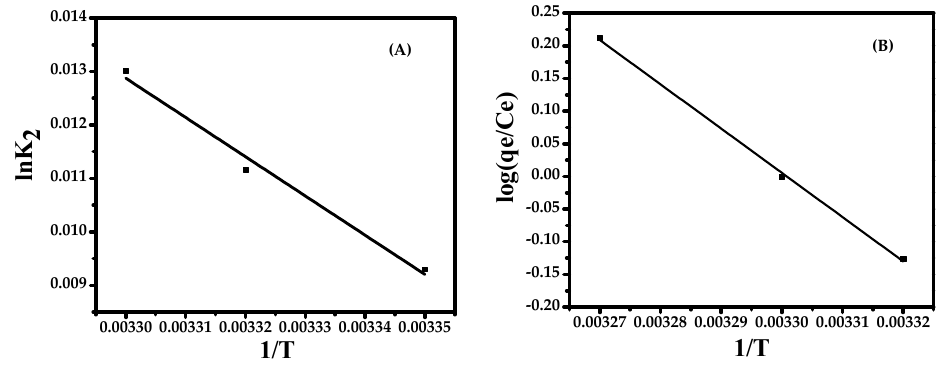
Figure 7. ( A )The Arrhenius plot and ( B ) the van’t Hoff plot. Figure 7. ( A ) The Arrhenius plot and ( B ) the van’t Hoff